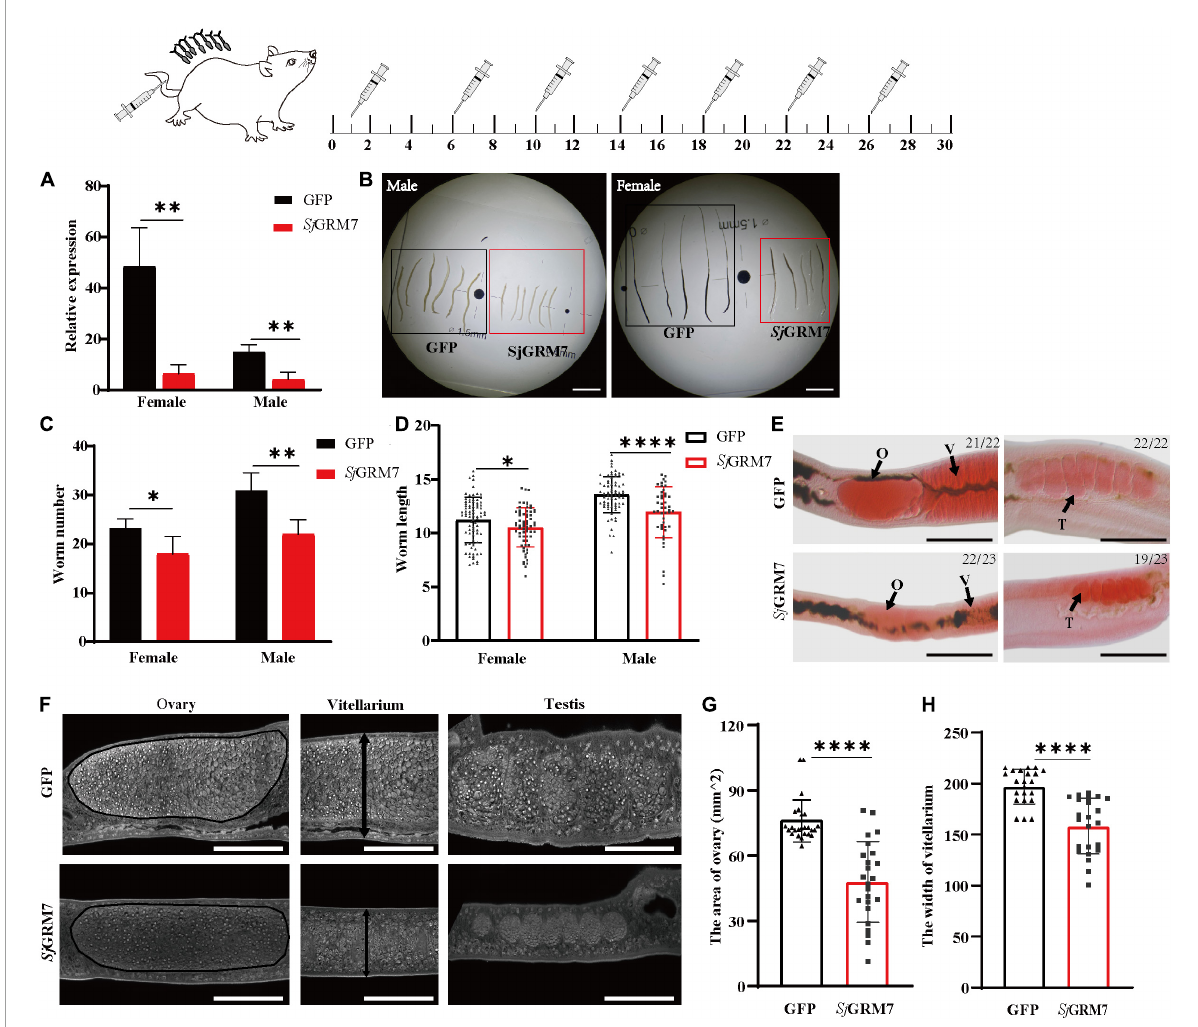
FIGURE4 Effects of dsRNA-mediated knockdown of Sj GRM7 in vivo. The top is a flow chart of in vivo interference. On the 1st, 6th, 10th, 14th, 18th, 22nd, and 26th days after cercariae infection using the abdominal patch method, dsRNA was injected through the tail vein, and the hepatic portal vein was perfused on the 30th day for observation. Worms were continuously treated with 10 µ g Sj GRM7 and GFP dsRNA in vivo . (A) Sj GRM7 transcript relative mRNA levels in the Sj GRM7 dsRNA group. (B) Morphological changes in the worms captured at 30 dpi. (C) Comparison of worm numbers between GFP and Sj GRM7 dsRNA groups. (D) Comparison of worm length between the GFP and Sj GRM7 dsRNA groups. (E) Morphological changes in the gonads of female and male worms were observed by carmine staining. (F) Adult worms from the treatment group were analyzed by confocal laser scanning microscopy. (G) The area of the largest cross-section of the ovary of female worms was measured using ImageJ. (H) The width of the largest cross-section of the vitellarium of female worms was measured using the ImageJ software. O, oocytes; E, eggs; T, testis; GFP, green fluorescent protein; dpi, days post infection; dsRNA, double-stranded RNA; GRM, metabotropic glutamate receptor. Scale-bars: (E) 200 µ m; (F) 50 µ m. ∗∗∗∗ P < 0.0001, ∗∗ P < 0.01, * P <